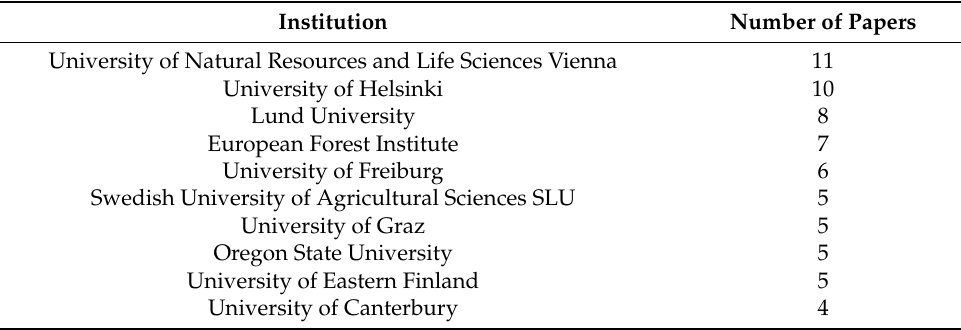
Table 3. Institutions with the most papers in the